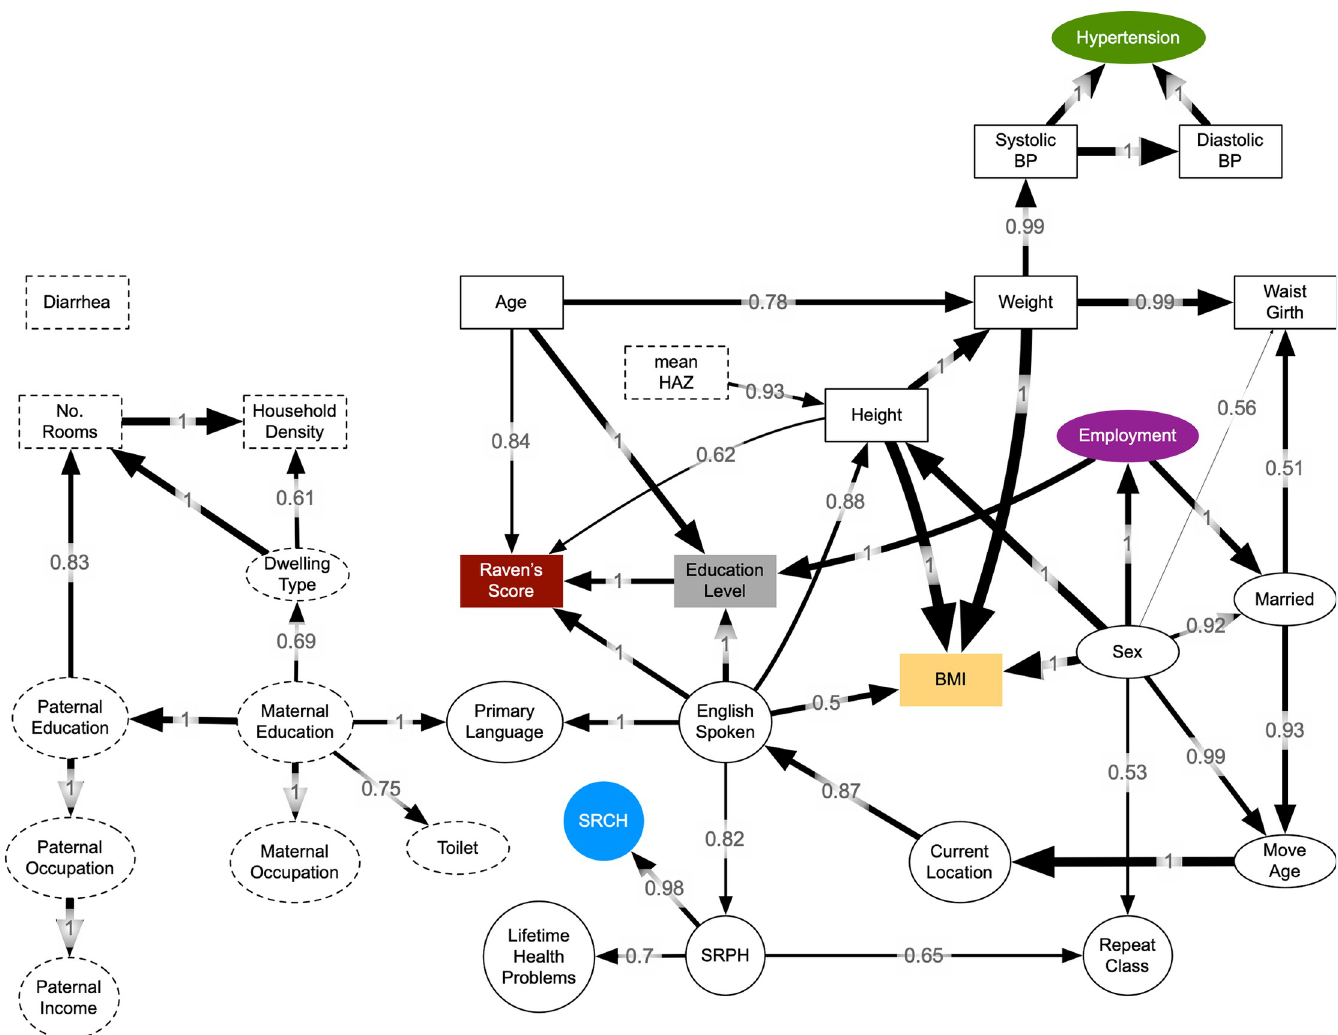
Fig 2. Bayesian network showing associations that were robust in � 50% of 7,500 bootstrap samples. Continuous nodes are shown as rectangles, and categorical nodes as ellipses; childhood nodes are indicated by dashed outlines, and adolescent nodes by solid outlines. Arc width is proportional to the change in the Bayesian information criterion (BIC): Thicker arrows indicate a larger change in BIC and evidence of a more informative association. Numbers indicate the proportion of bootstrap iterations that supported a given arc. The main outcomes are highlighted (hypertension, Raven’s score, SRCH, BMI, educational level, and employment status). The direction of associations is based on the maximum likelihood. BP, blood pressure; HAZ, length/height-for-age z score; No., number of; SRCH, self-reported current health; SRPH, self-reported past childhood